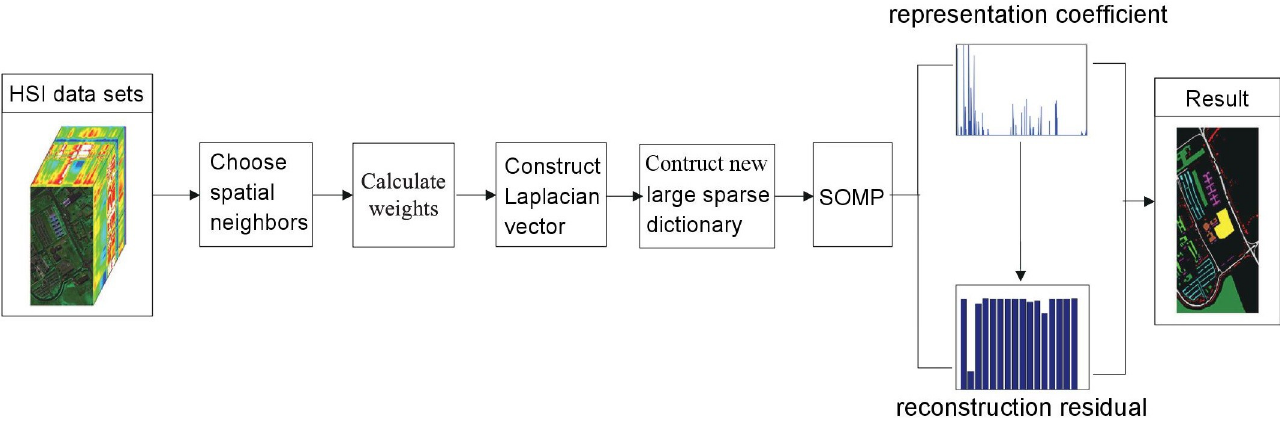
Fig 1. The procedure of